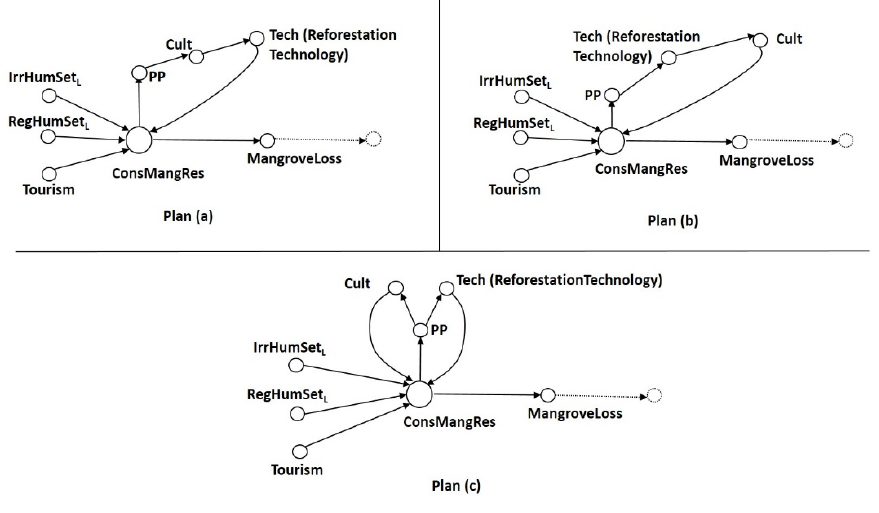
Figure 5. Plan ( a ), Plan ( b ), and Plan ( c ).